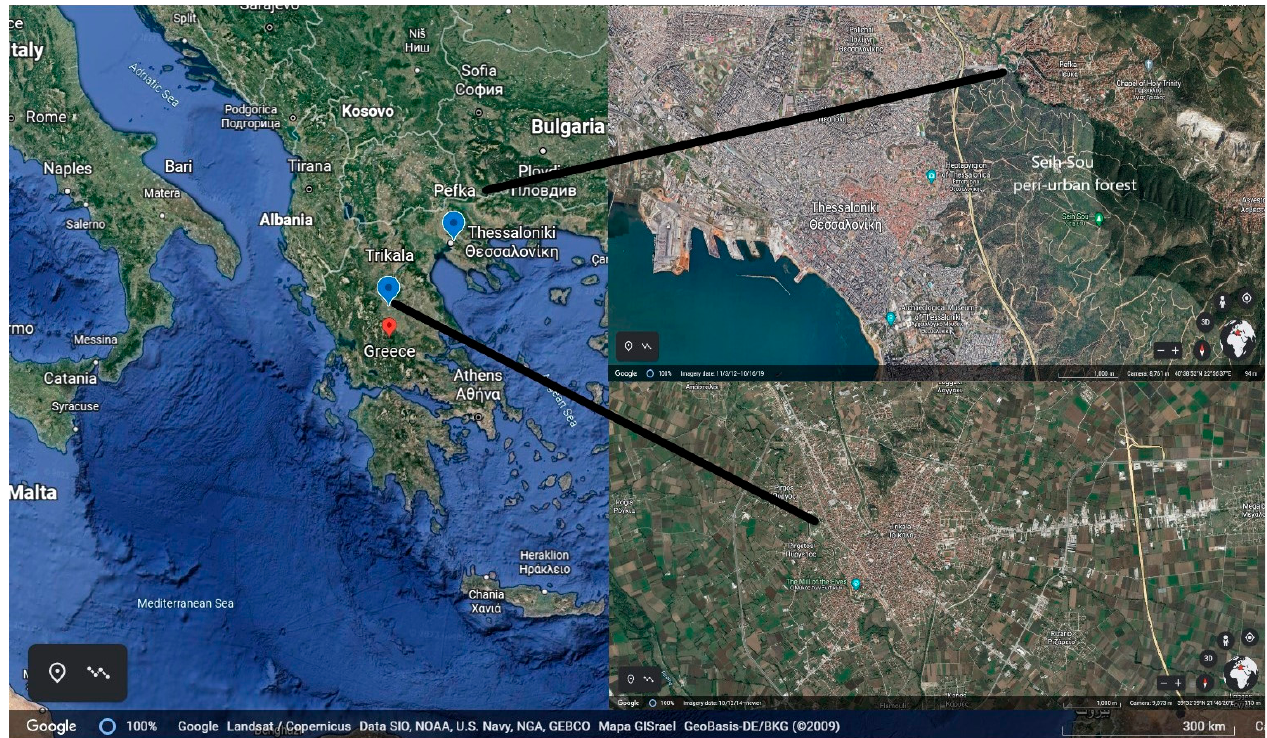
Figure 2. The location of the urban and rural study areas in Greece. The top-right map shows the urban area of Pefka and the Seih Sou peri-urban forest of the metropolitan area of Thessaloniki. The bottom-right map shows the map of Trikala in the rural area of Thessaly in central Greece (source: adapted from Google Earth).